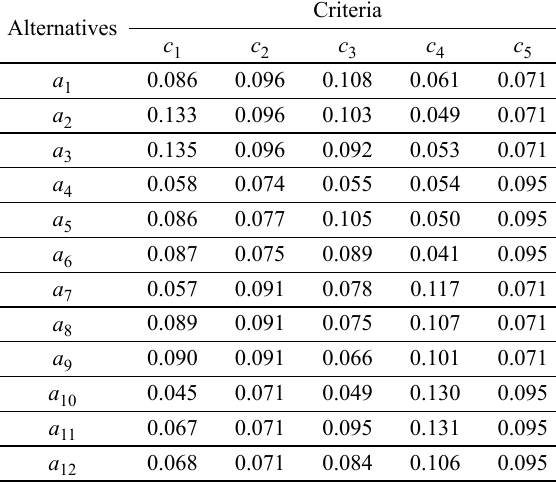
Table 5. Normalized decision-making matrix